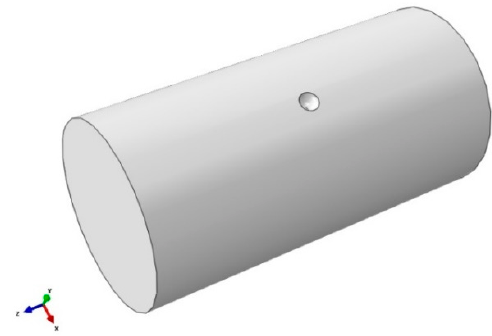
Figure 13. Pre-corroded steel wire model with regular a corrosion pit ( λ = 1.0). Table 2. Life of pre-corroded steel wire with a regular corrosion pit ( η = 0.25%). S / MPa n λ x /